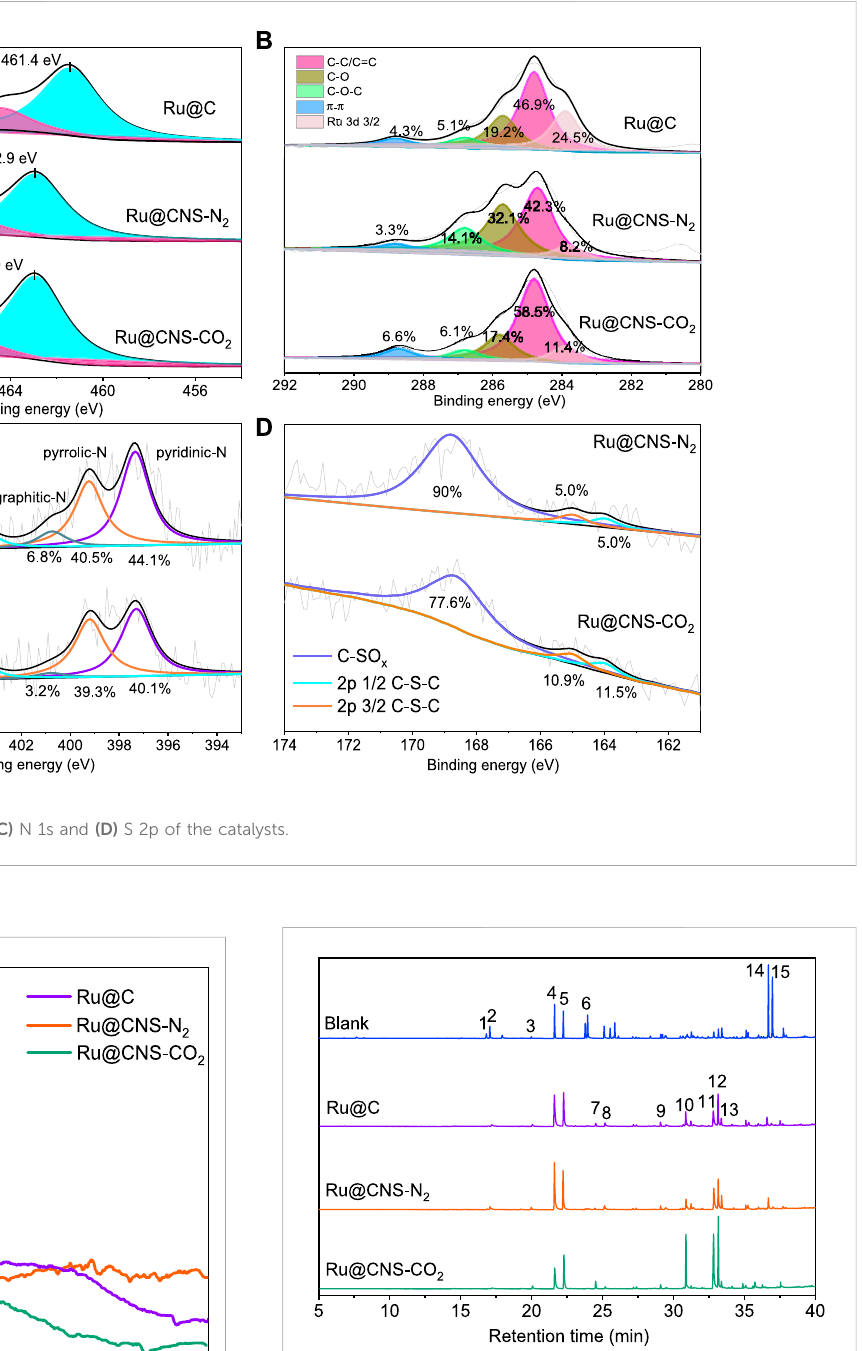
FIGURE 6 TICs of the products from lignin depolymerization over different